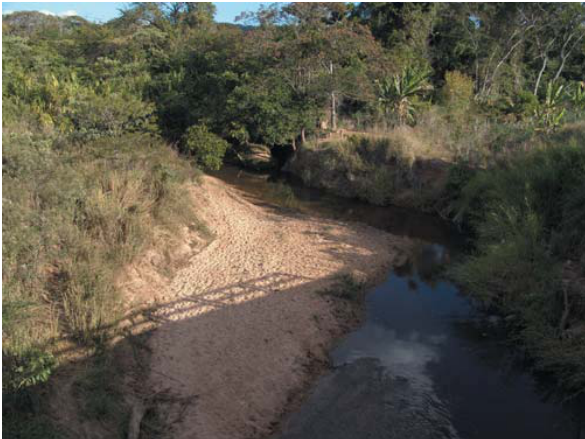
Fig. 5. Type locality of Rineloricaria osvaldoi , rio Vermelho, rio Araguaia basin,